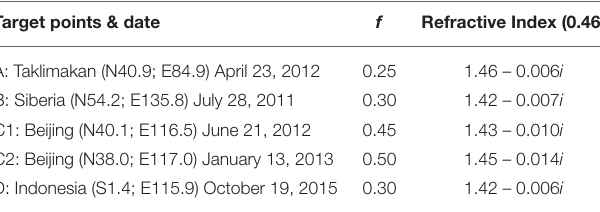
TABLE 1 | Retrieval results for the aerosol characteristics (refer to Figure 4